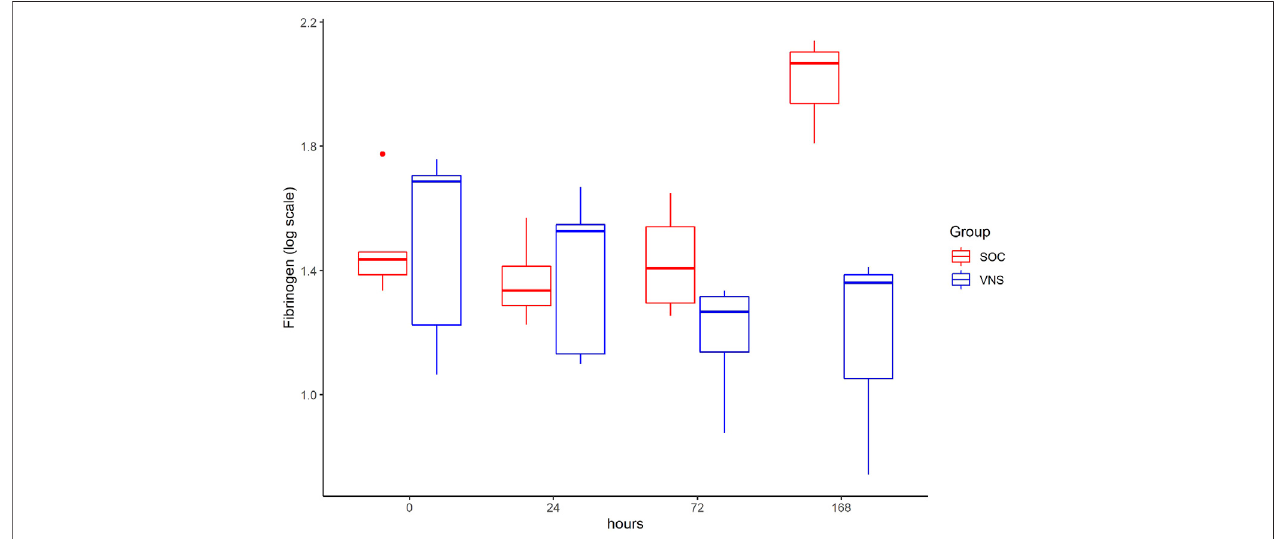
FIGURE11| MedianFibrinogenlevelwithInterquartile RangeofpatientsreceivingauricularVagusStimulation (VNS=blue)andpatientsonlyreceivingStandardof Care (SOC = red) after 0, 24, 72, and 168 h of study inclusion.